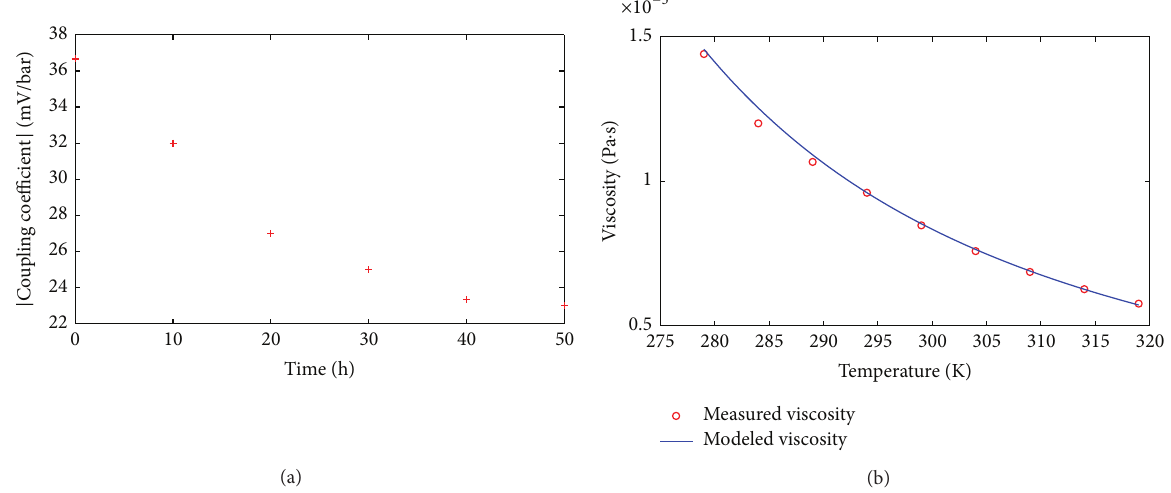
Figure 7: (a) |𝐶 𝑆 | versus time at room temperature for sample BereaUS5 and 5 × 10 −3 M. (b) The relationship between viscosity and temperature.